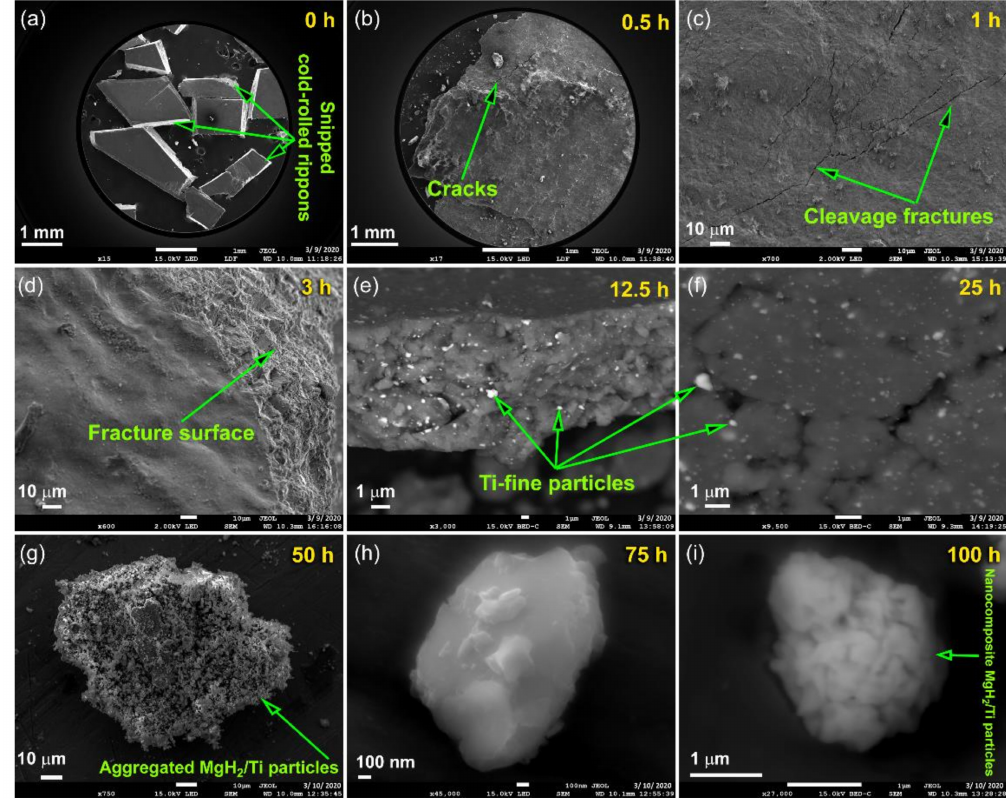
Figure 7. FE-SEM images of Mg-strips obtained after CR for 150 passes and then RBM for ( a ) 0, ( b ) 0.5, ( c ) 1, ( d ) 3, ( e ) 12.5, ( f ) 25, ( g ) 50, ( h ) 75, and ( i ) 100 h of RBM